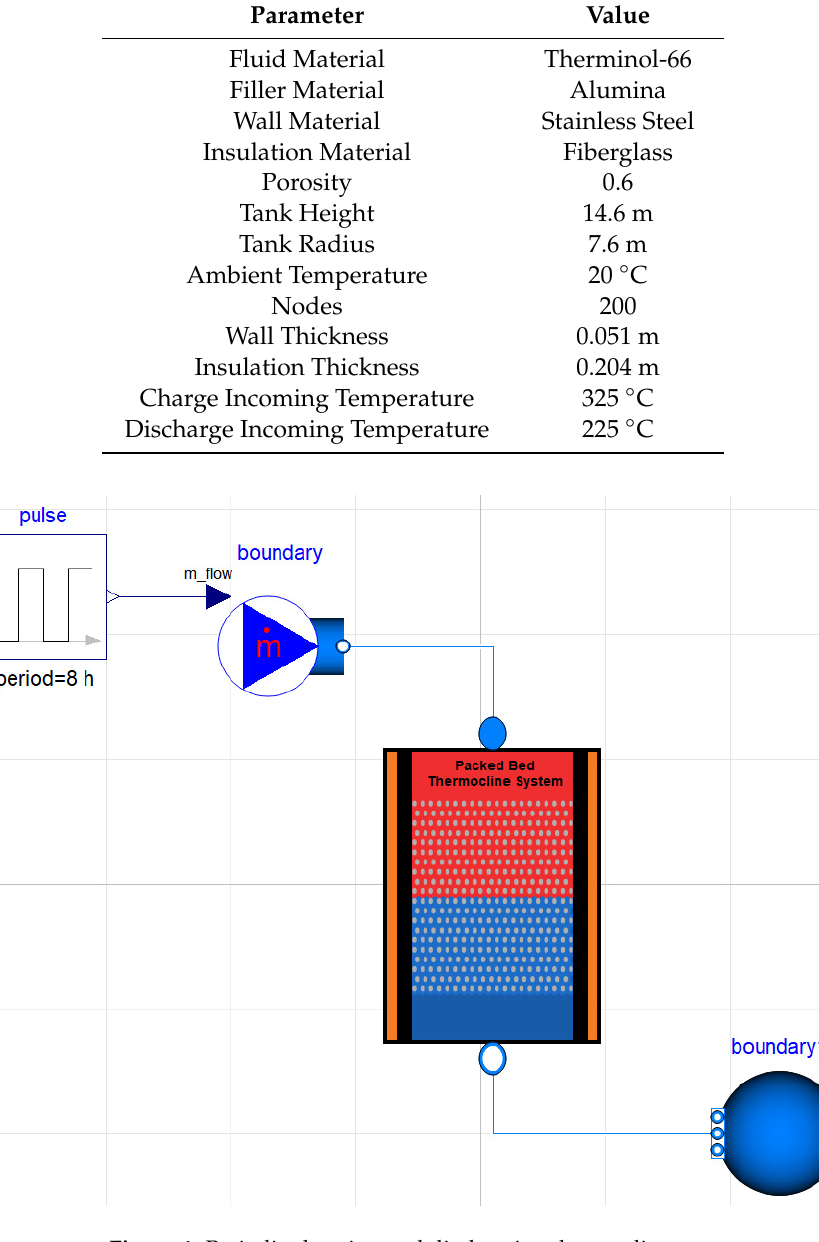
Figure 5. Fluid and filler temperature at the axial locations of i = 1 (top of the tank), i = 50 (25% down the tank), i = 100 (50% down the tank), i = 150 (75% down the tank), and i = 200 (bottom of the tank).